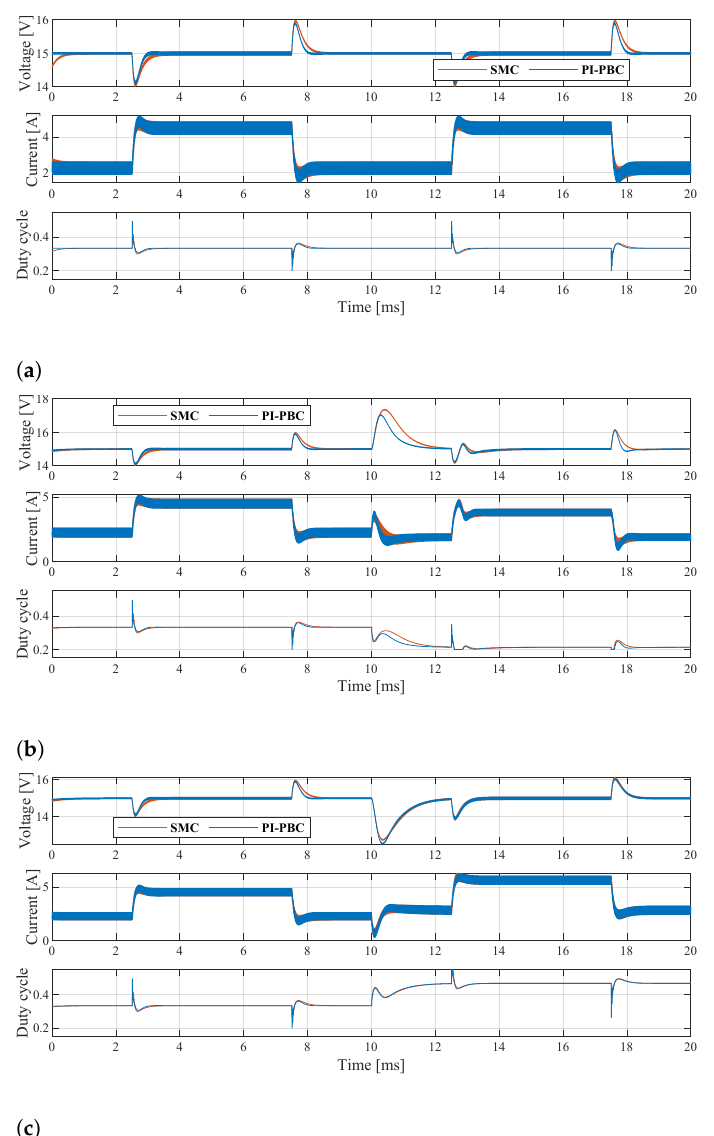
Figure 5. Simulated comparison between the PI-PBC and SMC approaches: ( a ) simulation results for the boost converter when the DC load is a 100 Hz square waveform that varies between 2 and 4 A with a 100 Hz square waveform and a duty cycle of 0.5; ( b ) input voltage changes from 10 to 12 V; ( c ) Input voltage changes from 10 to 8